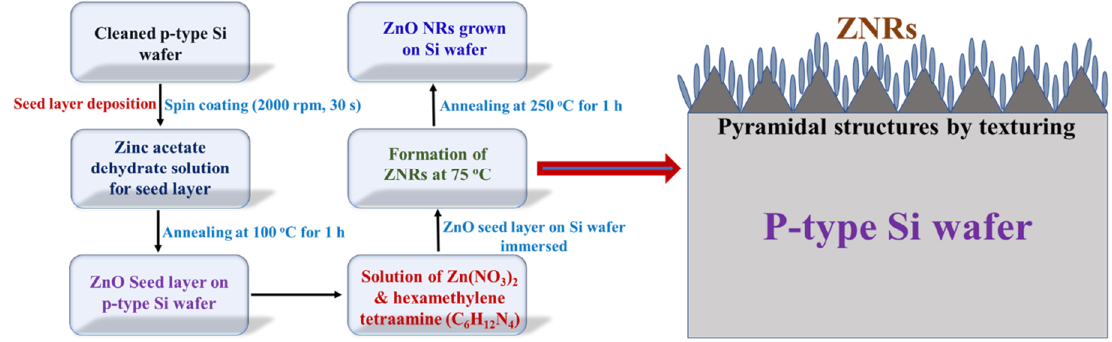
Figure 1. Schematic diagram of growth of ZnO nanorods (NRs) on a textured Si wafer.